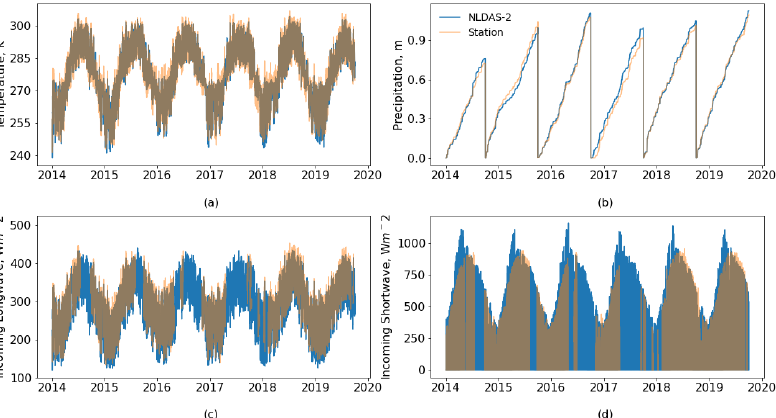
(Figure 4a), with a negative mean bias of − 0.7 K and − 0.4 K in NLDAS-2 during the accumulation and melt periods, respectively (Table 3). Total precipitation was higher in NLDAS-2 (compared to the Station) for all water years except WY 2015 (Figure 4b). However, NLDAS-2 total precipitation from the onset of the snow season to peak SWE was lower in WYs 2014, 2015, 2017, and 2019, and higher in WYs 2016 and 2018 (Table 4).